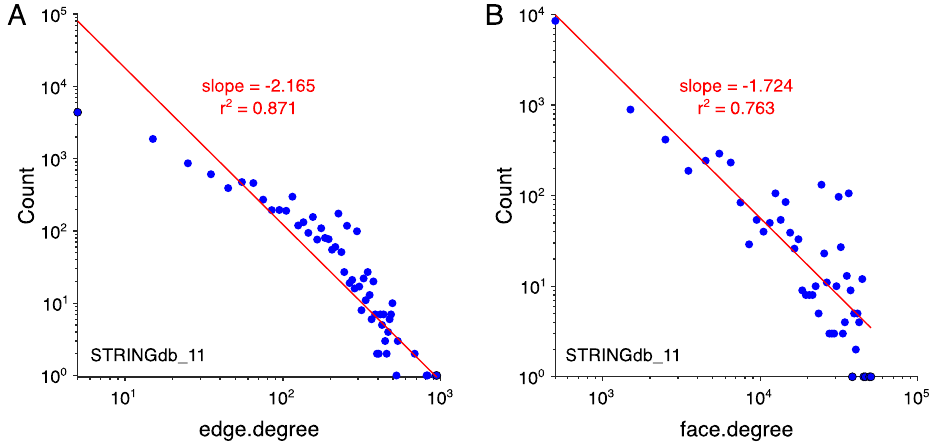
Figure 2. Degree distributions in PPI network. ( A ) Log-log plot of edge-degree distribution with linear fit of power law signature. The edge-degree distribution is identical for the 1D graph and 2D simplicial complex. ( B ) Log-log plot of face-degree distribution with linear fit of power law signature. Faces are only present in the 2D simplicial complex